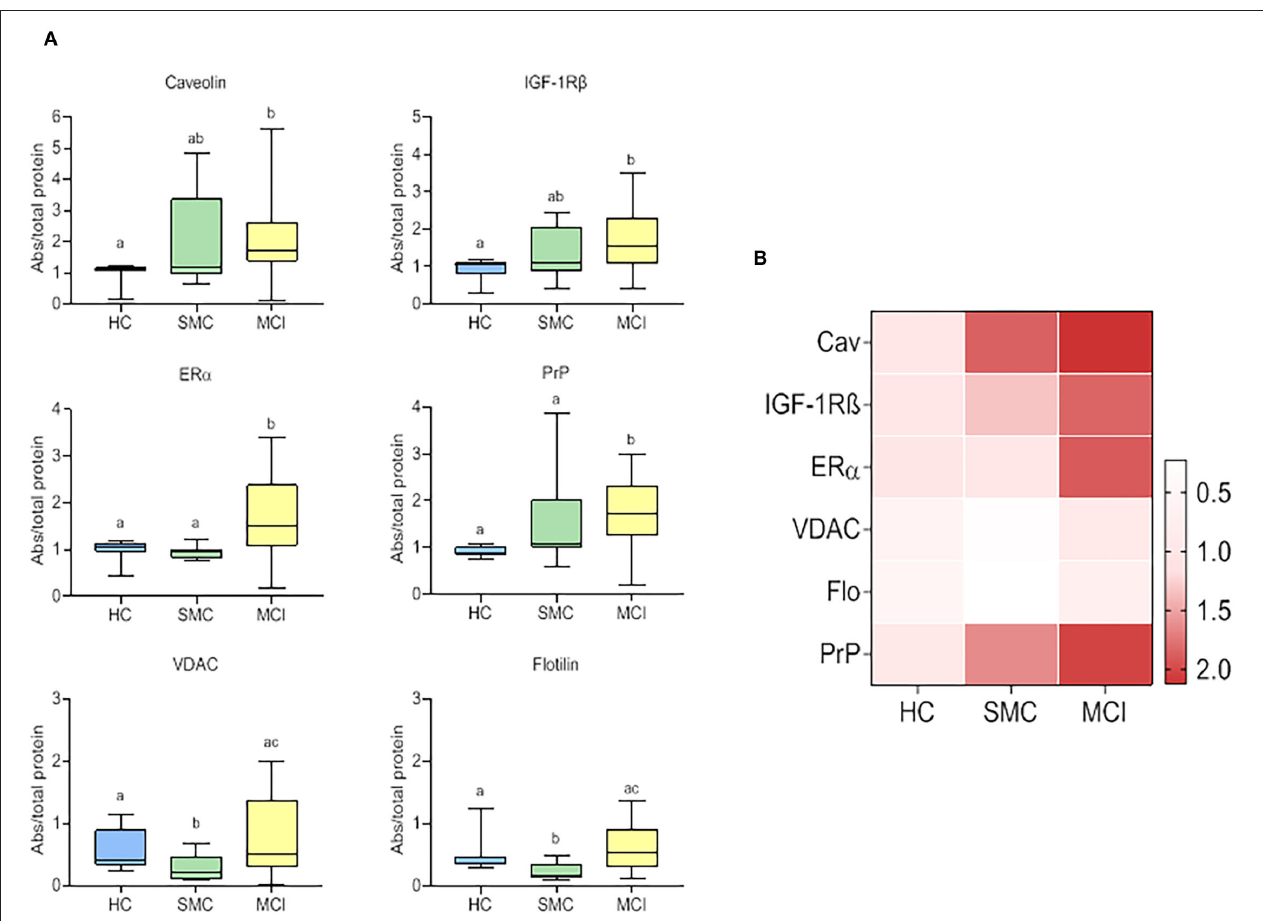
FIGURE 1 | Box plots for individual signalosome protein contents in the CSF of HC, SMC, and MCI groups (A) . The data were submitted to one-way ANOVA or Kruskal–Wallis test followed by post-hoc Tukey’s HSD test, Games–Howell or Mann–Withney U -test where appropriate. The different letters in each plot indicate statistically significant differences with p < 0.05. (B) Heatmap representation of mean protein contents in the three groups (B)